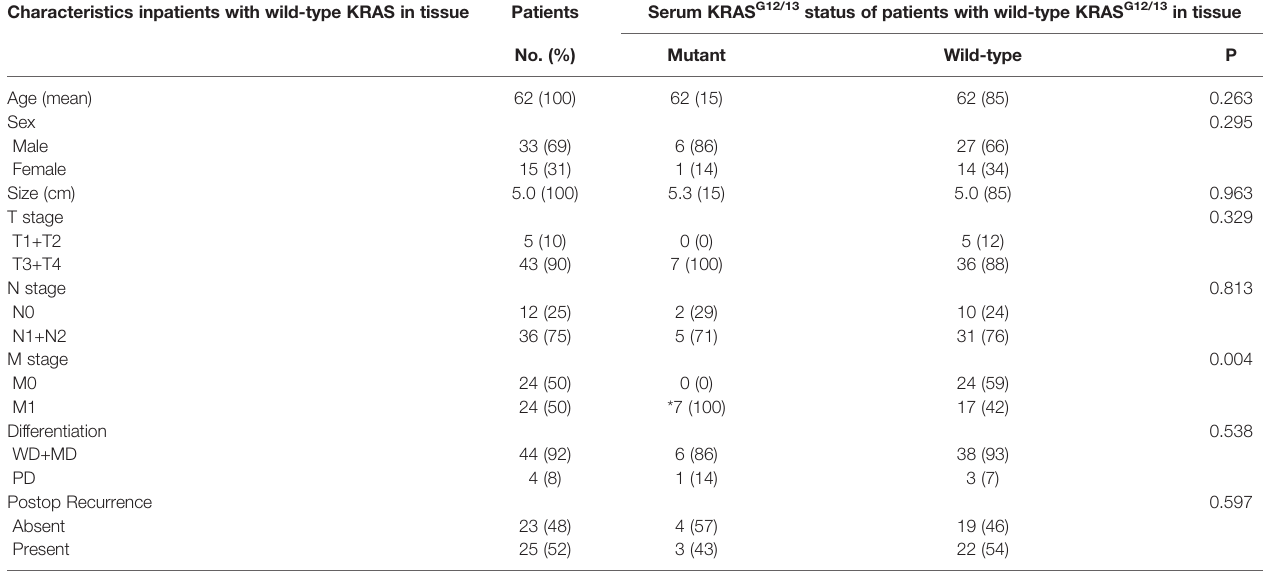
Postop, Post-operative; WD, well differentiated; MD, moderately differentiated; PD, poorly differentiated. *7 cases described in Table 3 .